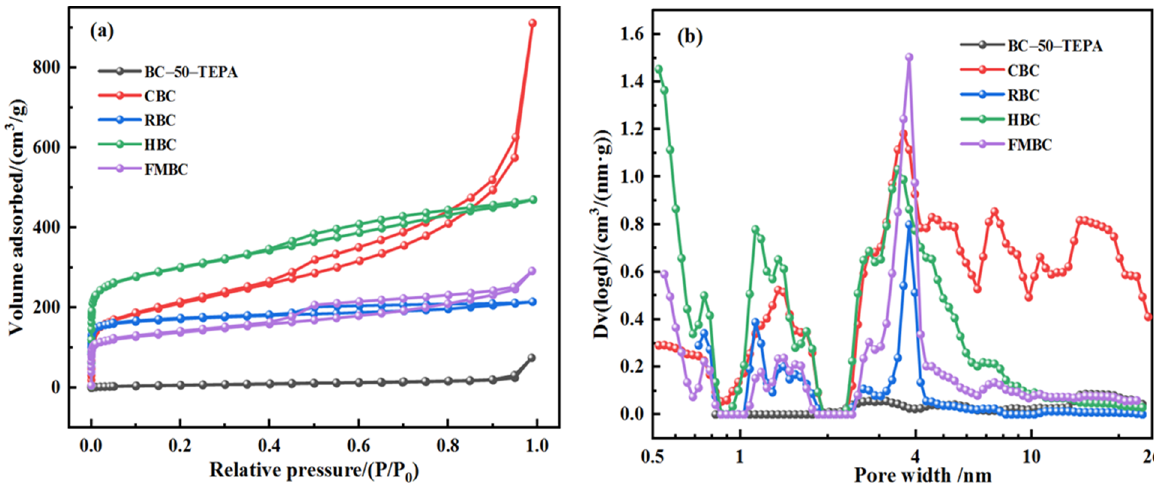
Figure 5. ( a ) Nitrogen adsorption − desorption isotherms and ( b ) pore diameter of biochar from dif- ferent activation methods and